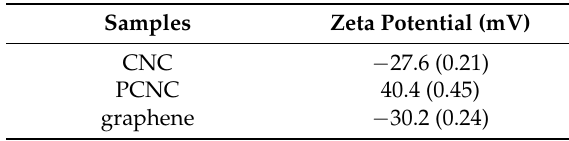
Table 1. Zeta potential of CNC, PCNC, and graphene.